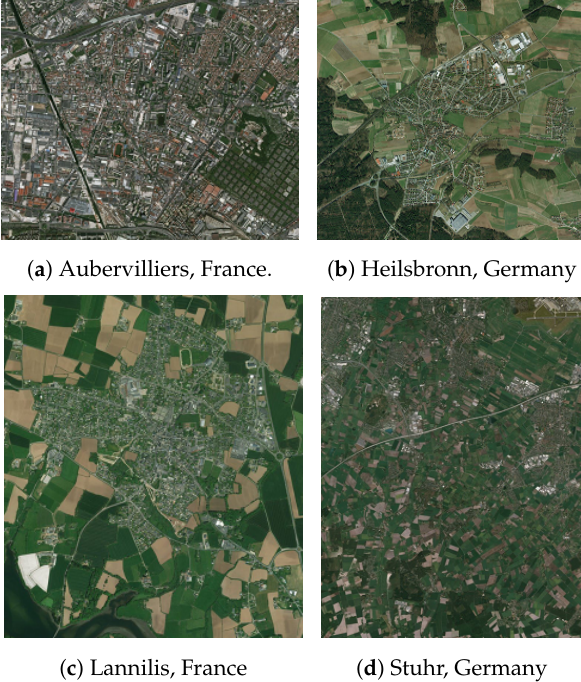
Figure 4. Aerial view of the study areas (Bing